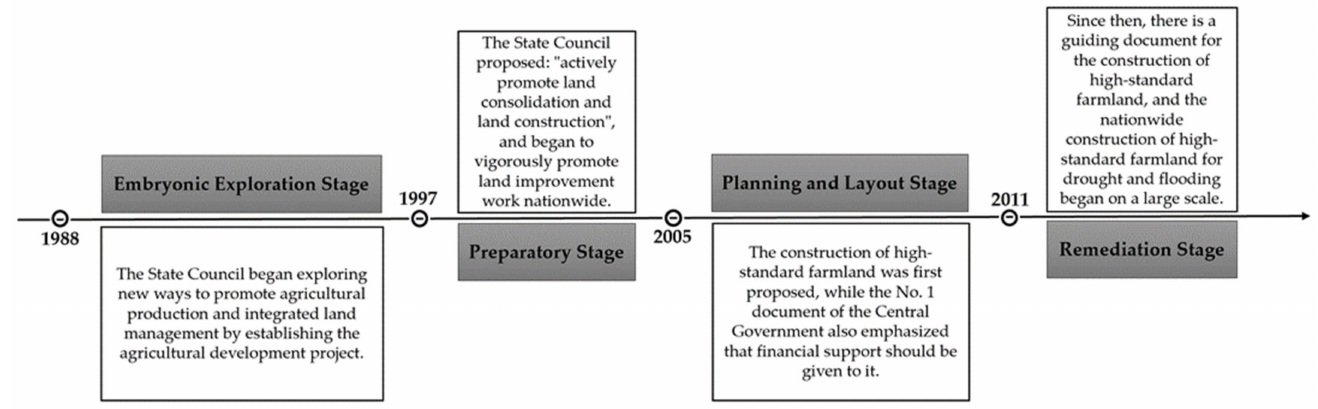
Figure 1. Different stages of high-standard farmland construction